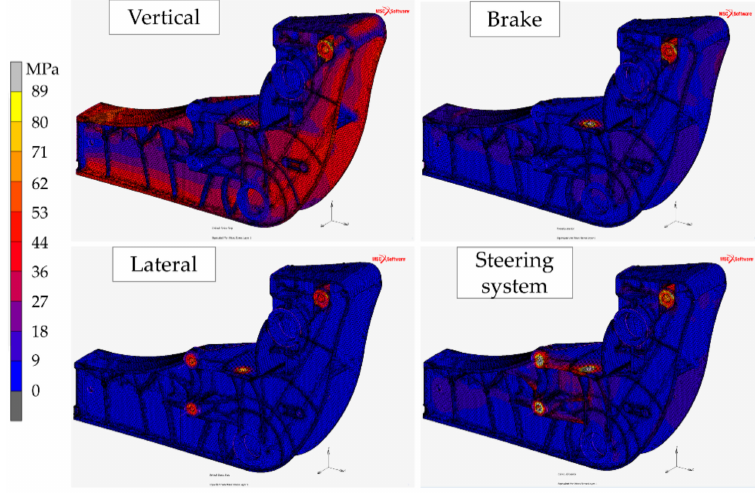
Figure 8. MSC Marc / Mentat Von Mises output for vertical, brake, lateral and hydraulic steering system load